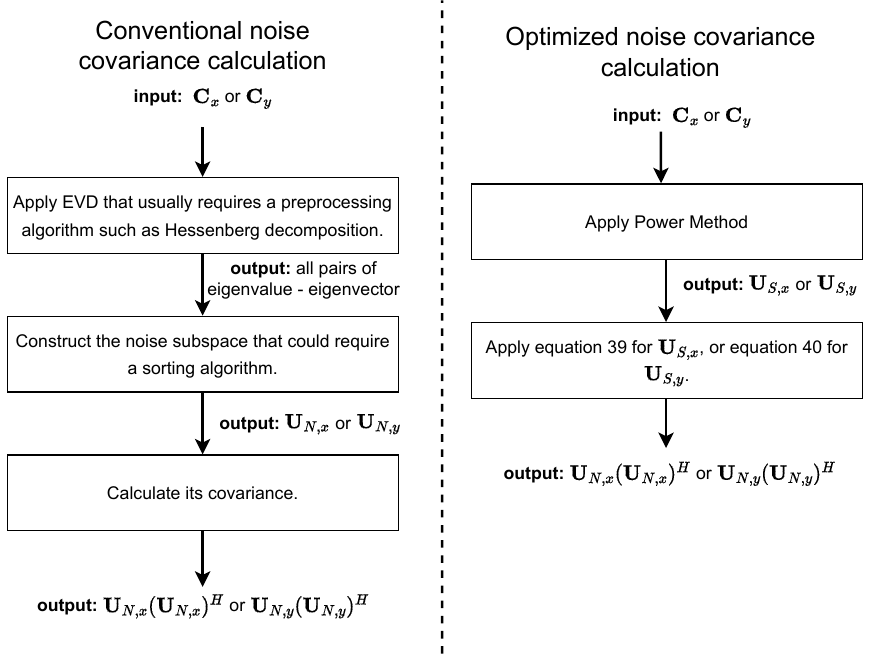
Figure 6. Algorithm overview of the two covariance noise subspace computations. The left method calculates that covariance directly, but the right one calculates indirectly via the signal